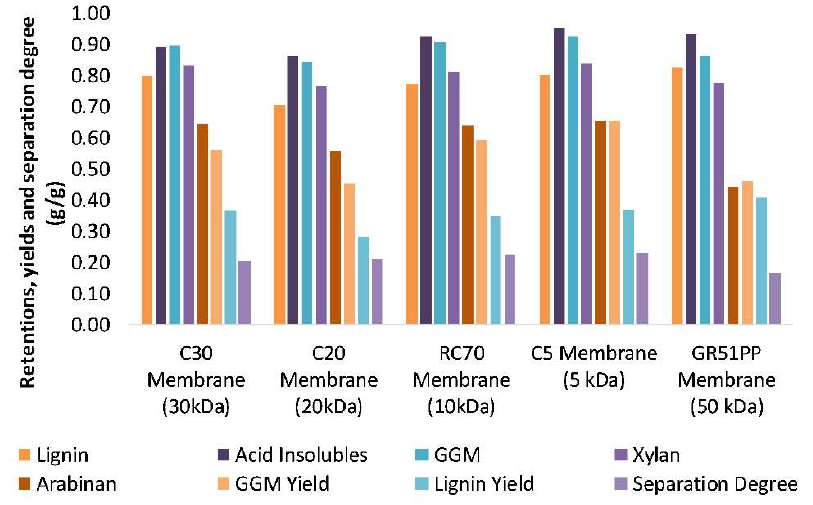
Figure 6. The average membrane retention, yield, and separation degree of the solutes from a volume reduction of 0% to 90%.